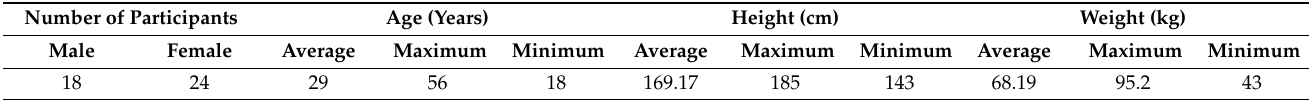
Table 1. Demographics of the participants.